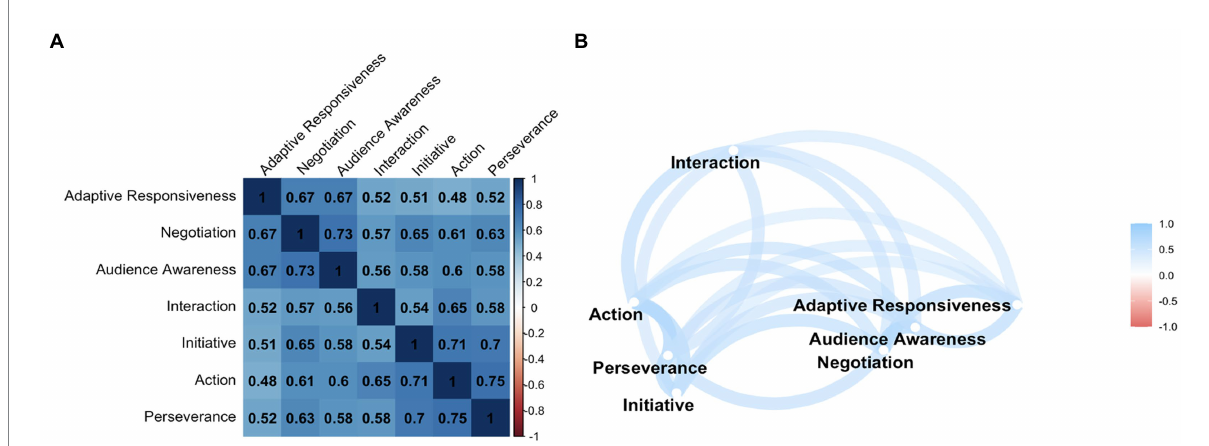
FIGURE 2 Correlation between items: (A) Spearman’s rank correlation coefficients matrix and (B) correlation network. Correlation between items: (A) matrix of Spearman’s rank correlation coefficients and (B) correlation network. The matrix contains the Spearman’s rank correlation coefficients between the 7 items of the SSC questionnaire. Colors indicate the direction and strength of the correlation, with positive correlations displayed in blue and negative correlations in red. Results in bold indicate statistical significance at the p < 0.05 level. All results are statistically significant. The correlation network is constructed from all pairwise correlations between items in (A) . Items are represented by nodes and are connected by edges. The red and blue lines represent negative and positive correlations, respectively. The color saturation of the line widths is proportional to the strength of the correlation.